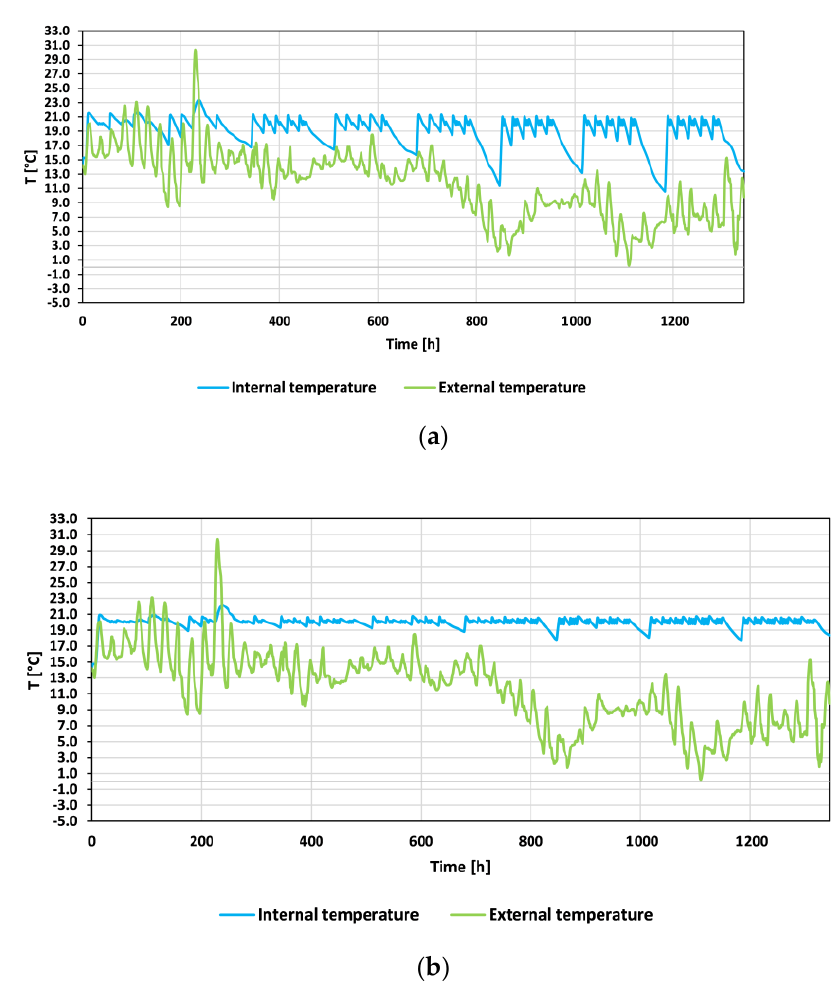
Figure 7. Scenario 1 — External (green) and internal (blue) temperatures [°C], for user 8 ( a ) and user 65 ( b ) along the simulation time [h].